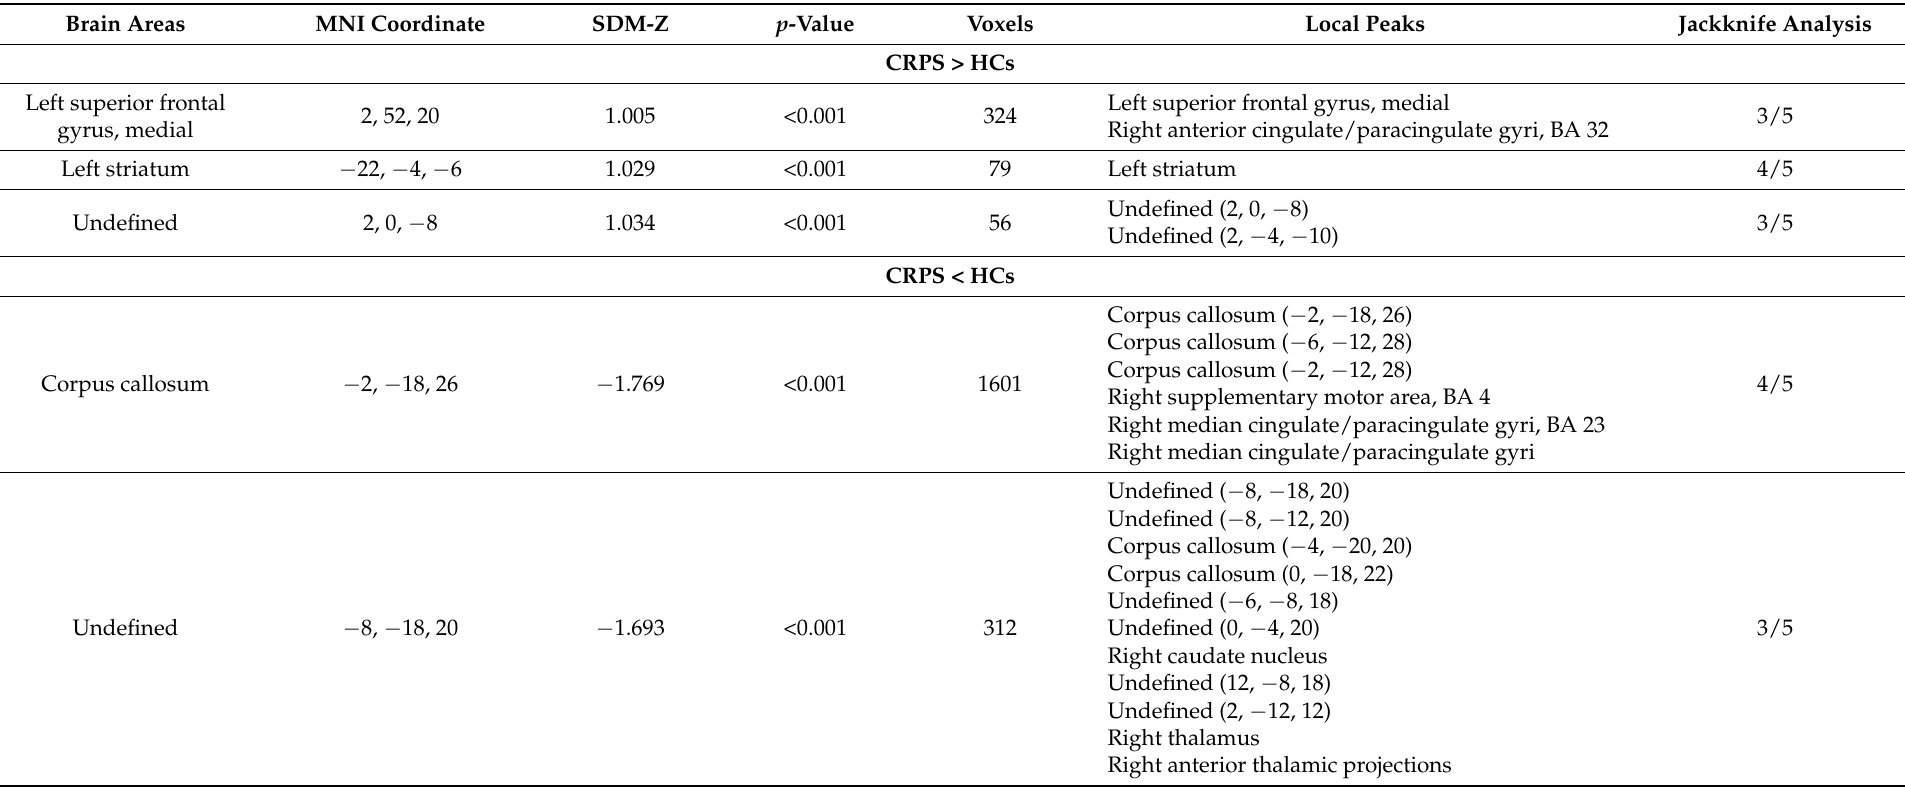
Table 3. Significant and consistent GMV abnormality in the main